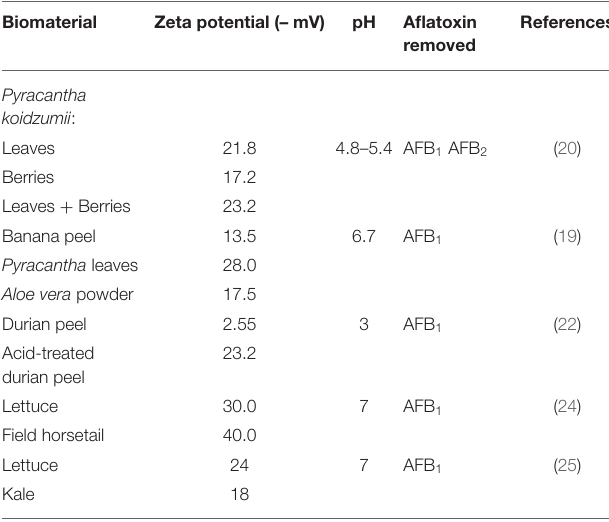
TABLE 4 | Zeta potential values of the agro-waste-based materials used for aflatoxins adsorption. Biomaterial Zeta potential (– mV) pH Aflatoxin